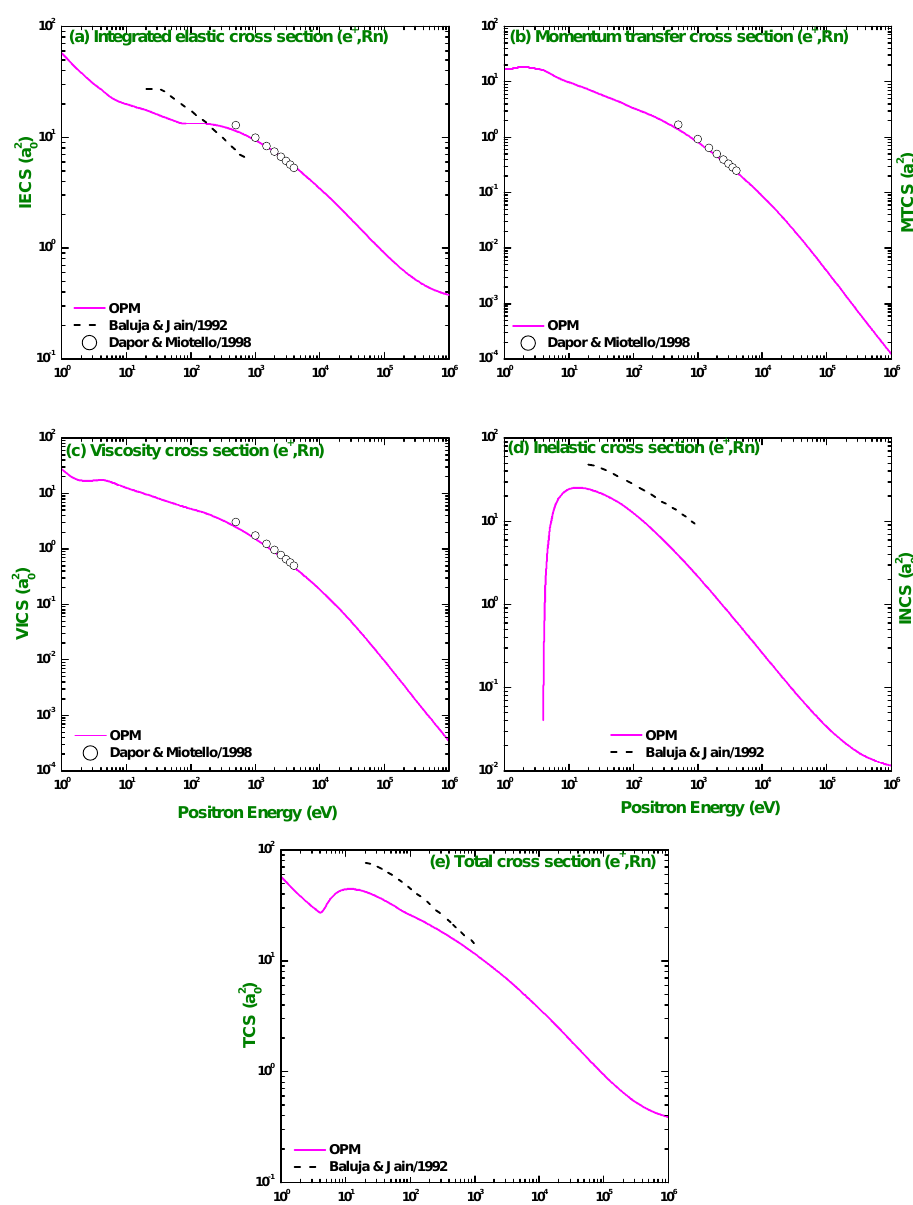
Figure 25. Energy dependence of the ( a ) integrated elastic, ( b ) momentum-transfer, ( c ) viscosity, ( d ) inelastic and ( e ) total cross sections for positron impact scattering from neutral radon atoms. Presented are the theoretical calculations — for the present results, − − − for Baluja and Jain [12] and ◦ ◦ ◦ for Dapor and Miotello